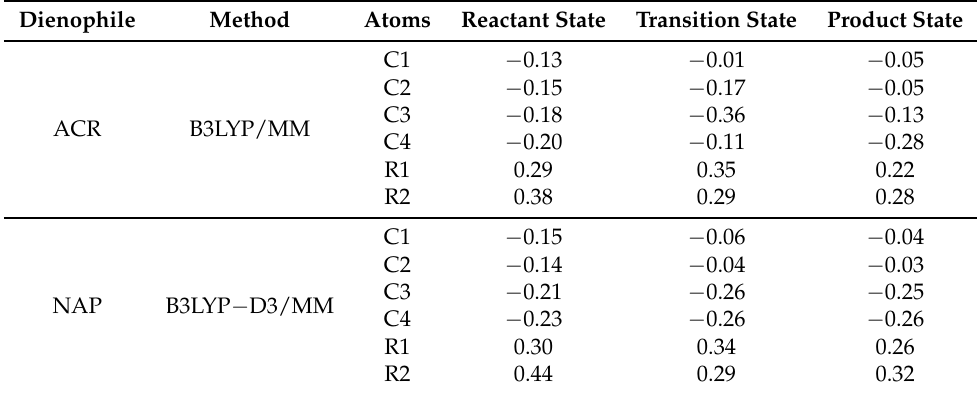
Table 3. The Mulliken partial charges (in a.u.) of all atoms shown in Figure 2 for the Diels–Alder reactions between cyclopentadiene and acrylonitrile (ACR), 1-4-naphthoquinone